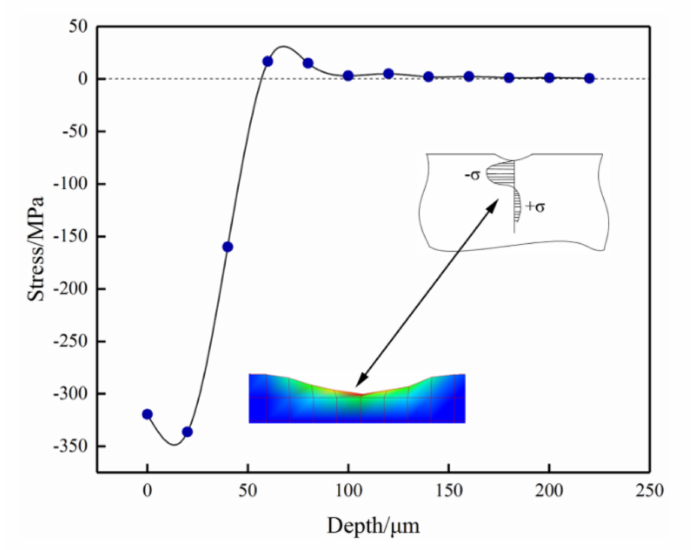
Figure 4. Stress distribution in the crater.